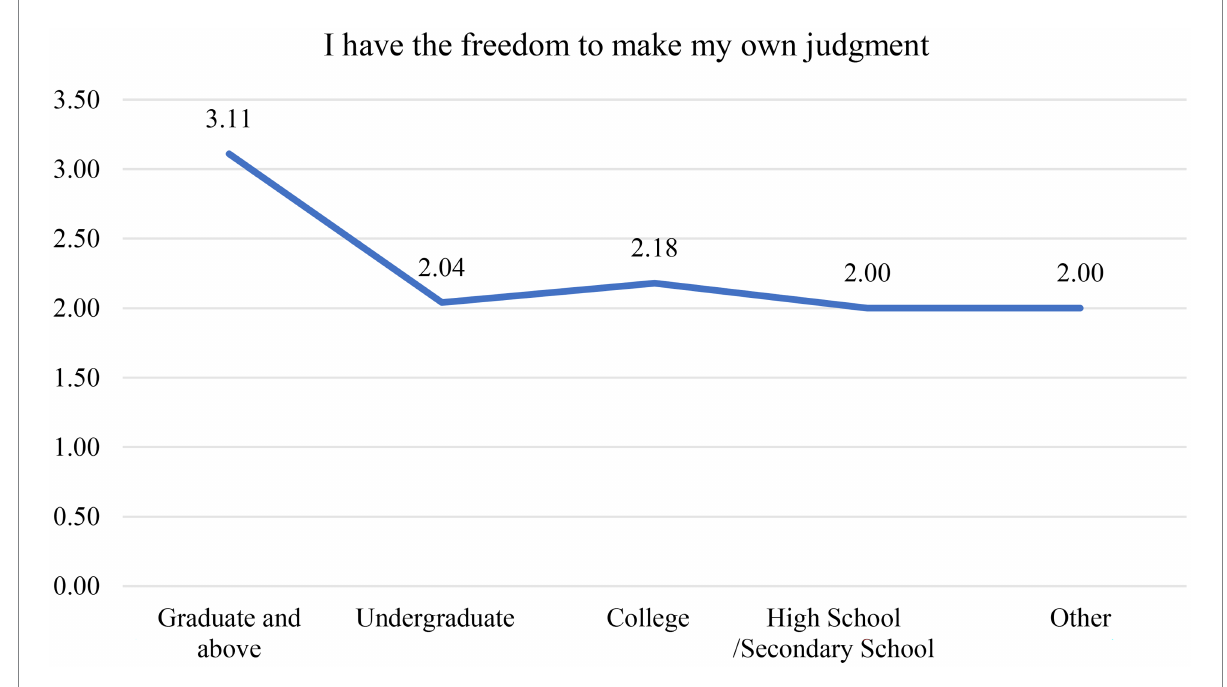
FIGURE 1 Analysis of variance for the question “I have the freedom to make my own judgments.”